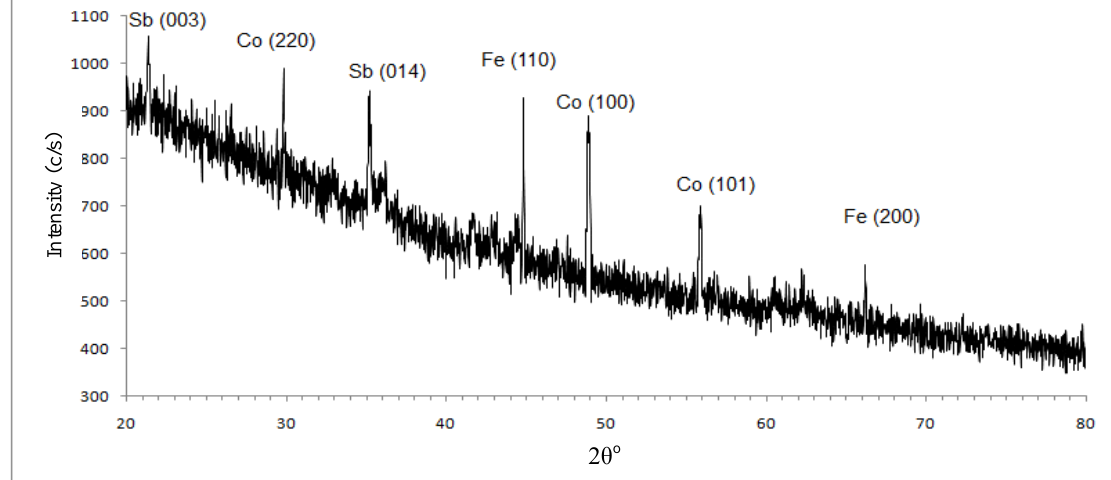
Fig. 4: X-ray diffraction pattern for FeCoSb alloy nanoparticles that obtain by exploded wire method with different diameter in DDDW